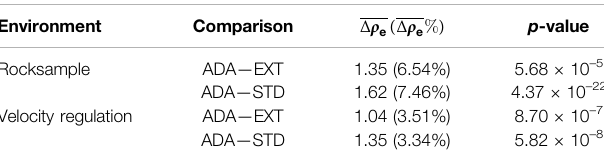
TABLE 5 | Performance of